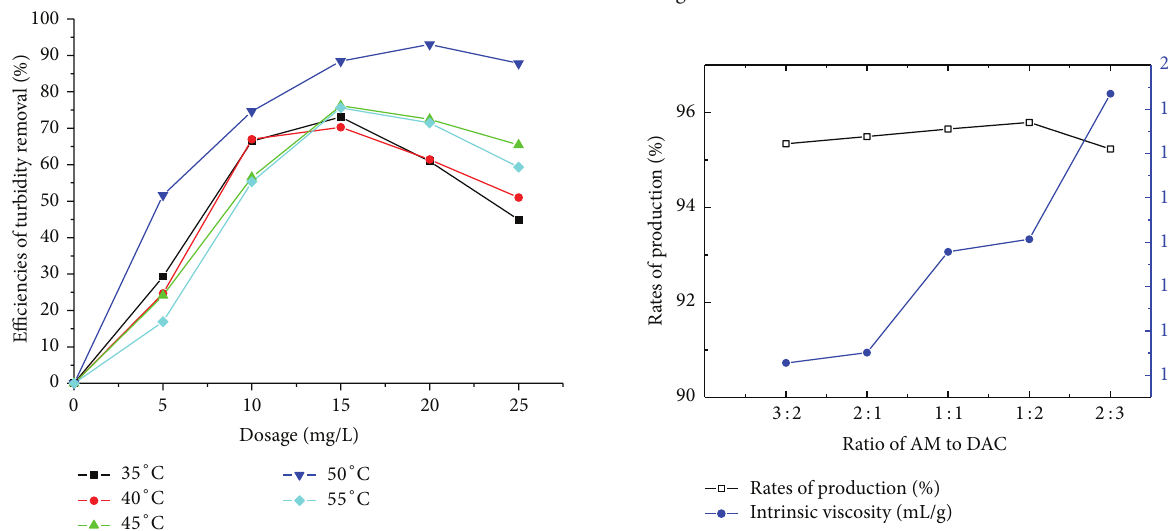
Figure 13: Effects of reaction temperature on COD removal for sewage.